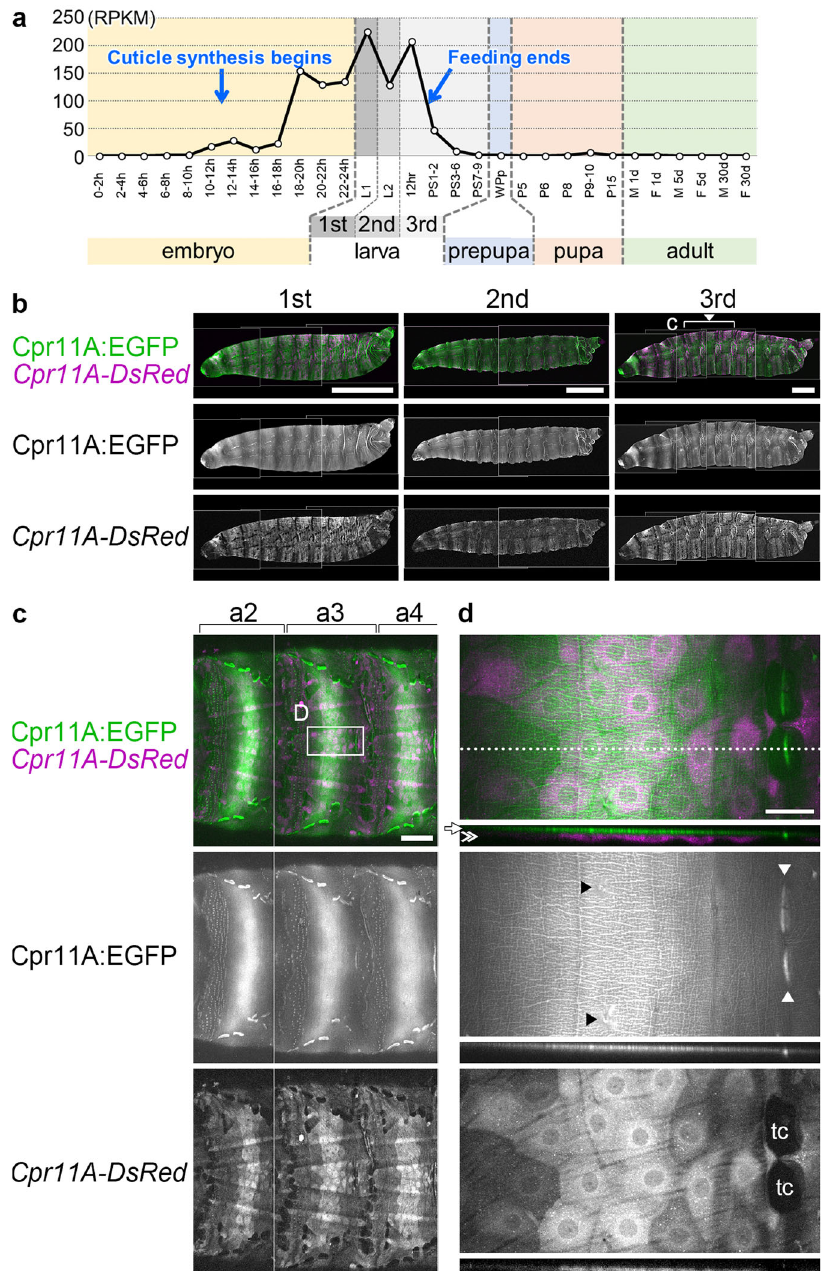
Fig. 4 Cpr11A expression. a The temporal RNA expression pro fi le of Cpr11A extracted from modENCODE developmental transcriptome. h, hours after egg laying (AEL); 1st/L1, fi rst instar larva; 2nd/L2, second instar larva; 3rd, third instar larva; 12 hr, 12 h post-molt (still feeding); PS1-2, dark blue gut stage (early wandering); PS3-6, light blue gut stage; PS7-9, clear gut stage; WPp, white prepupa; P, pupal stages; M, male; F, female; d, days after eclosion. The approximate timings of the beginning of fi rst instar larval cuticle synthesis (embryonic stage 15 12 , approximately 11:20-13h AEL 27 ) and the cessation of feeding (the beginning of wandering) are indicated. b EGFP and DsRed signals observed in live fi rst, second and third instar larvae harboring Cpr11A:EGFP and Cpr11A-DsRed reporters. Larvae are viewed from the lateral sides. Bars, 500 μ m. Anterior is to the left and dorsal is up. c The dorsal region of abdominal segments 2-4 (a2-4) (corresponding to the bracket region in b ) of a third instar larva. Bar, 200 μ m. d Upper panels are magni fi cations of the boxed region in c , and optical cross-sections at the position indicated by the broken line are shown in lower panels. b – d are projections of focal planes spanning the entire thickness of the cuticle and the epidermis. Apical (external) is up in cross-sections. Arrow, cuticle; double arrowhead, epidermal cells; tc, tendon cells; white arrowheads, muscle attachment sites in the cuticle; black arrowheads, sensory hairs. Bar, 50 μ the epicuticle. Cpr11A:EGFP formed a layer that spanned the layer consisting of proteins and chitin) 32 . The fl uorescently tag- basal portion of the TwdlD layer and the most apical portion of ged Tweedle proteins Tb:GFP 33 and TwdlD:DsRed 28 have been reported to mark an apical region of the larval cuticle. In our the procuticle (Fig. 5b-e), indicating that Cpr11A:EGFP was observation, the two proteins colocalized in a layer apical to the localized around the epicuticle-procuticle boundary. The apical chitin-containing procuticle (Fig. 5a), and thus probably marked side of Cpr11A:EGFP signals were fl at while the basal side had